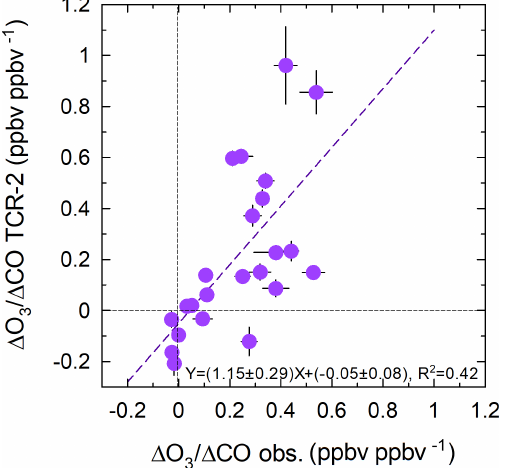
Figure 8. Correlations between (cid:49) O 3 /(cid:49) CO ratios from observa- tions and TCR-2.